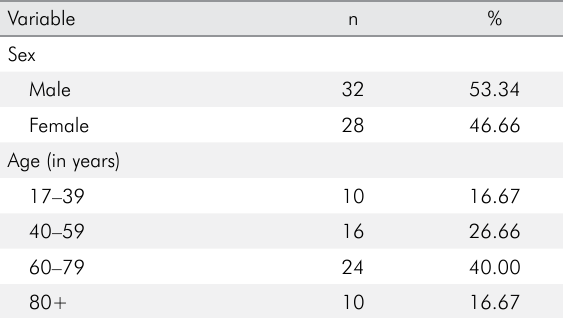
Table 2. Descriptive data of the sample